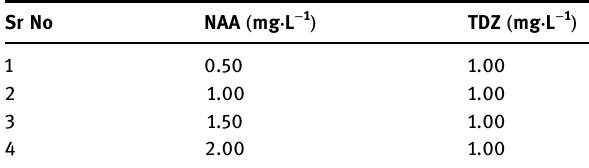
Table 1: C. sativa callus induction using di ff erent concentrations of NAA and TDZ